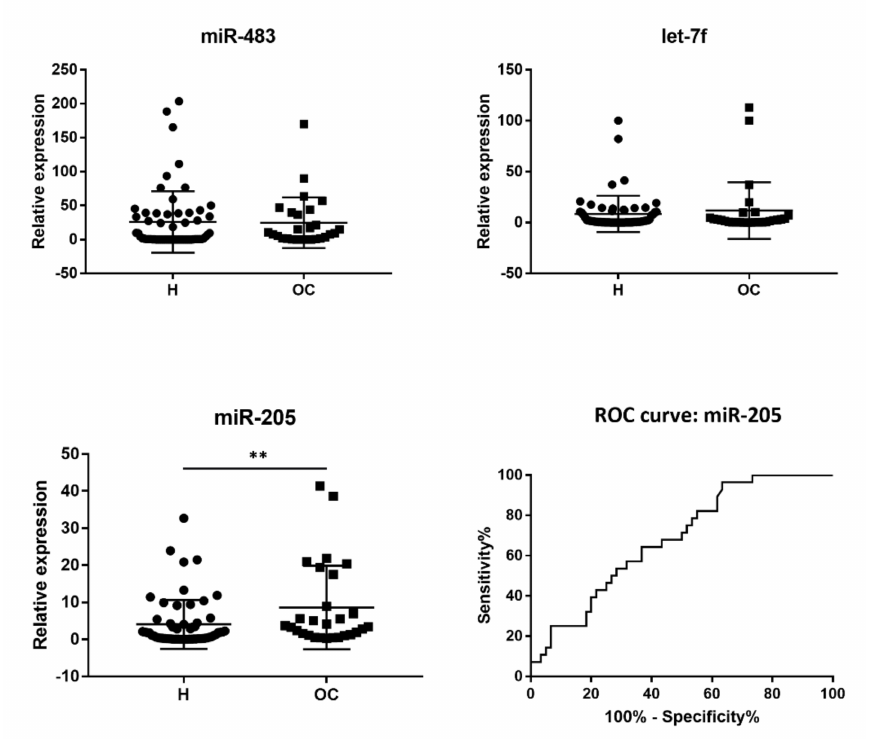
Figure 3. Scatter plot of miR-483-5p, miR-205-5p, and let-7f-5p expression in the plasma samples of patients suffered from ovarian cancer (OC) and in healthy controls (H). Significance was determined by Mann–Whitney U test between the ∆ CT values of healthy and malignant samples; ** p <